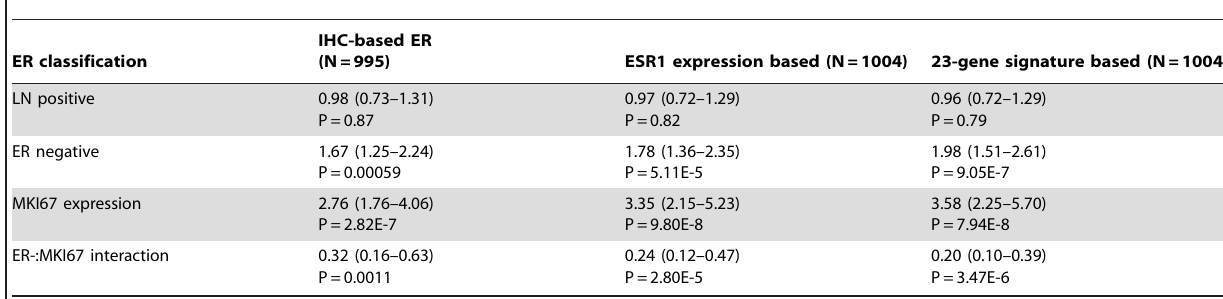
Table 3. Multivariate Cox regression of lymph node status, ER status, proliferation (MKI67) and their interaction in four reference cohorts with regard to IHC-based, ESR1-expression based and 23-gene signature based ER status.